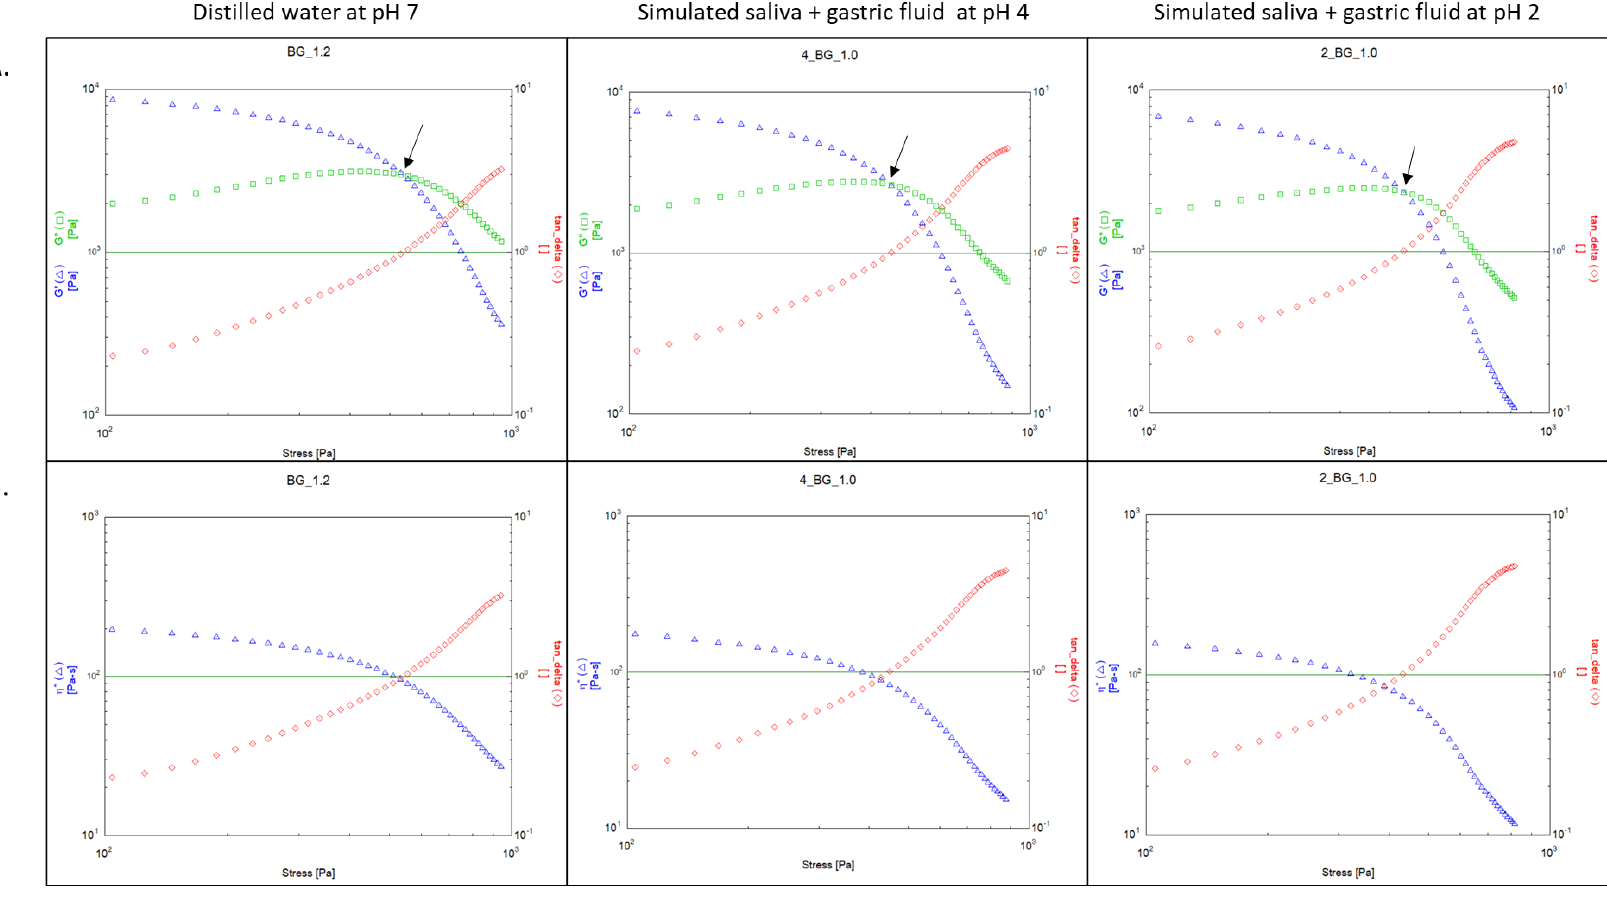
Figure 2. An example of pseudoplastic rheological behaviour observed in beta-glucan. Graphs show ( A ) rheological yield points (top half, y-axis left: G’ and G” in Pa, y-axis right: Tan ( δ ), x-axis bottom: shear stress in Pa) and ( B ) complex viscosity (bottom half, y-axis left: η * in Pa.s, y-axis right: Tan ( δ ), x-axis bottom: shear stress in Pa) plots as shear stress is gradually increased in distilled water (pH 7), simulated digestions with SDF-PPI (simulated digestion fluid proton pump inhibitor at pH 4) and SDF (simulated digestion fluid at pH 2). The black arrow in each plot indicates the yield point where Tan ( δ ) = 1. Note that the rheological behaviour does not change under chemically simulated digestion.